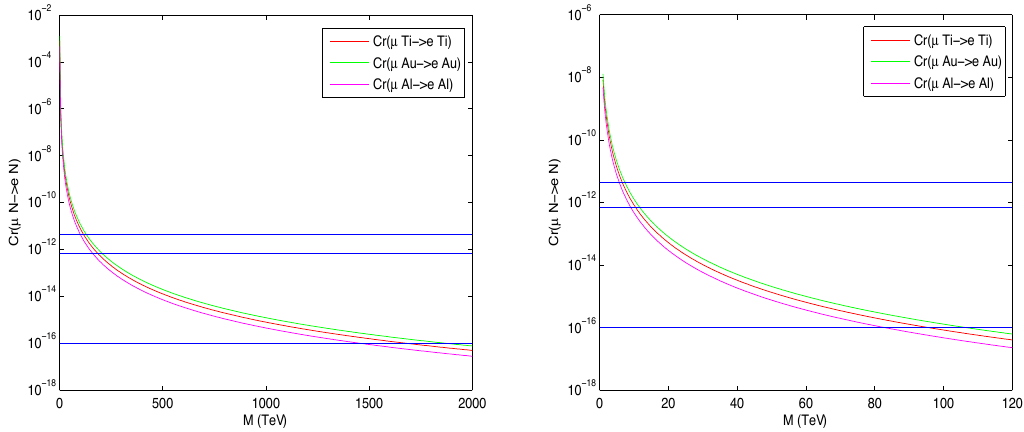
Figure 6 . The (cid:22) ! e conversing ratio Br( (cid:22) N ! e N ) versus the new neutral gauge boson mass m Z 0 (cid:17) M , for di(cid:11)erent nuclei: i) 48 Ti (red line), ii) 27 Al (magenta line), and iii) 197 Au (green line). 22 12 79 The three blue lines corresponding to Br( (cid:22) Ti ! e Ti ) (cid:20) 4 : 3 (cid:2) 10 (cid:0) 12 [90], Br( (cid:22) Au ! e Au ) (cid:20) 7 : 0 (cid:2) 10 (cid:0) 13 , and Br( (cid:22) Al ! e Al ) (cid:20) 1 : 0 (cid:2) 10 (cid:0) 16 are the SINDRUM-II current upper bounds [91] and the COMET expected sentisitvity [92], respectively. The left panel is created with (cid:18) ‘ = (cid:25)= 12